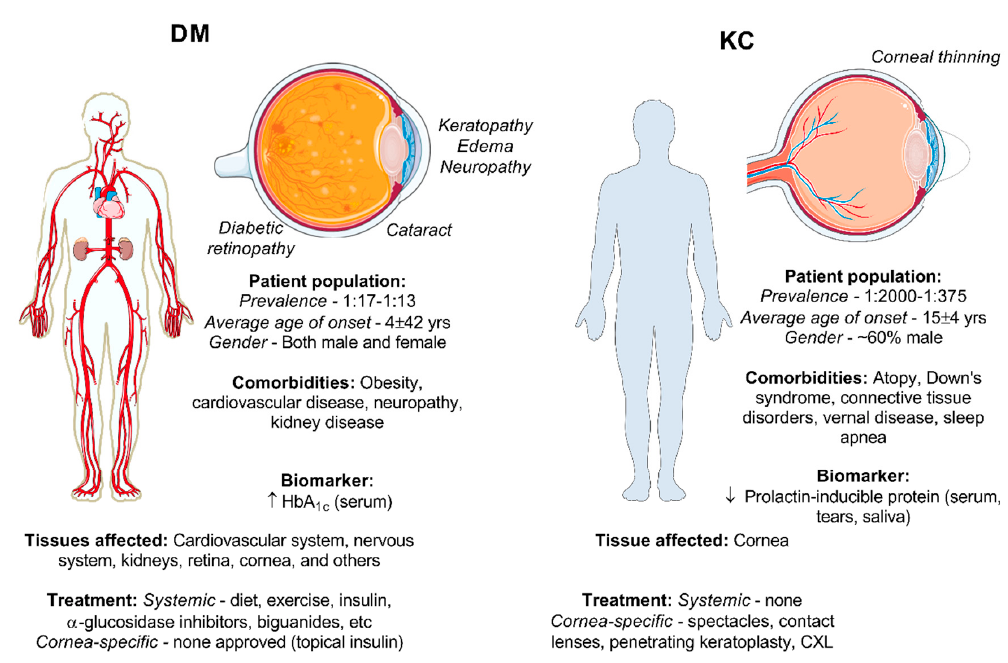
Figure 2. Comparison of the DM and KC condition based on the general patient population, systemic clinical features, ocular effects, and treatments for DM and KC. Pictorials modified from Medical